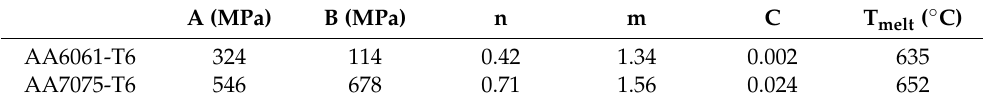
Table 3. Johnson–Cook’s parameters for AA7075-T6 and AA6061-T6 alloys [51,52]. A (MPa) B (MPa)